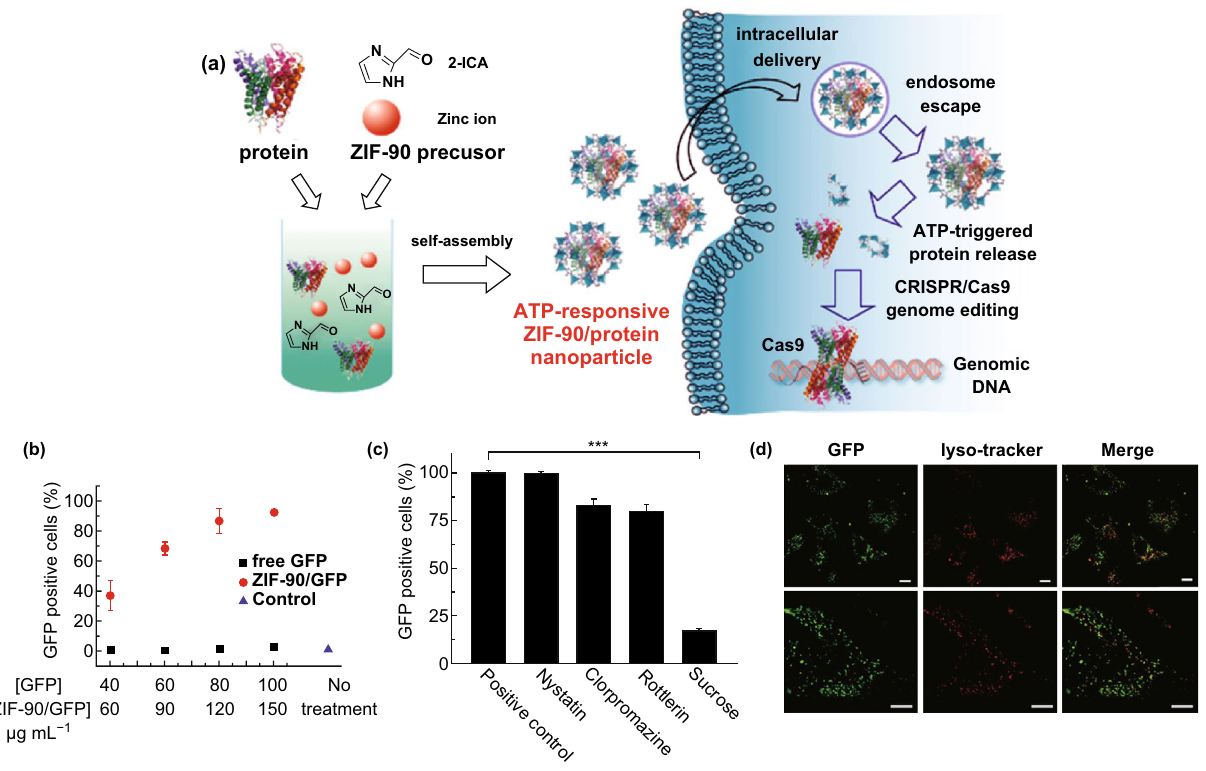
Fig. 14 a Schematic illustration of the synthesis of ZIF-90/protein nanoparticles and ATP-triggered protein release in the cell. b Cellular uptake efficiency of ZIF-90/GFP. c Cellular uptake efficiency of ZIF-90/GFP in the presence of different endocytosis inhibitors. d CLSM images of HeLa cells treated with ZIF-90/GFP. LysoTracker Red was used for endosome/lysosome staining. Scale bar: 10 μm. Reproduced with permission from Ref. [153]. Copyright 2019, American Chemical